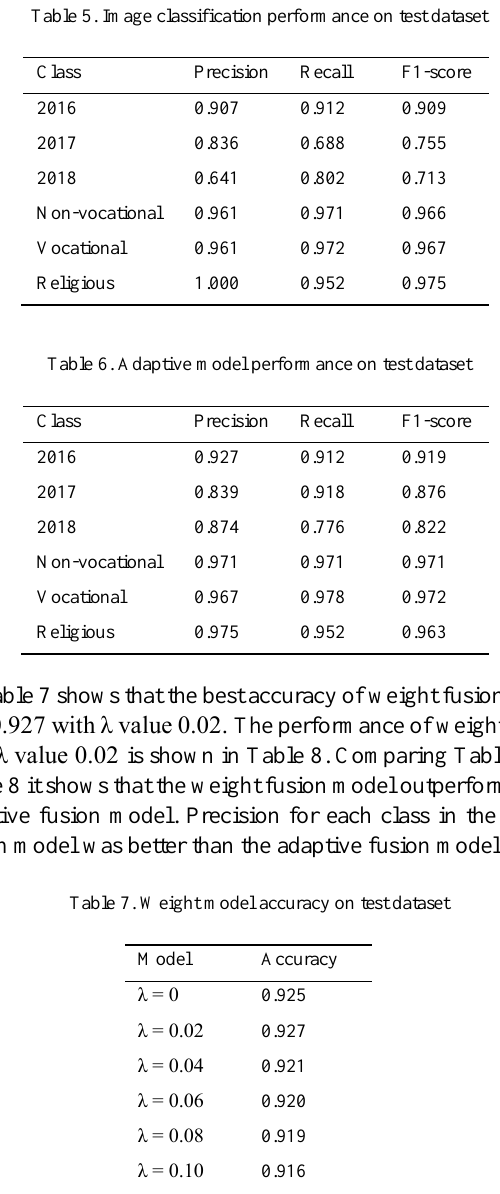
Fig. 5. Learning curve of text classification model Table 3. Text classification performance on test dataset